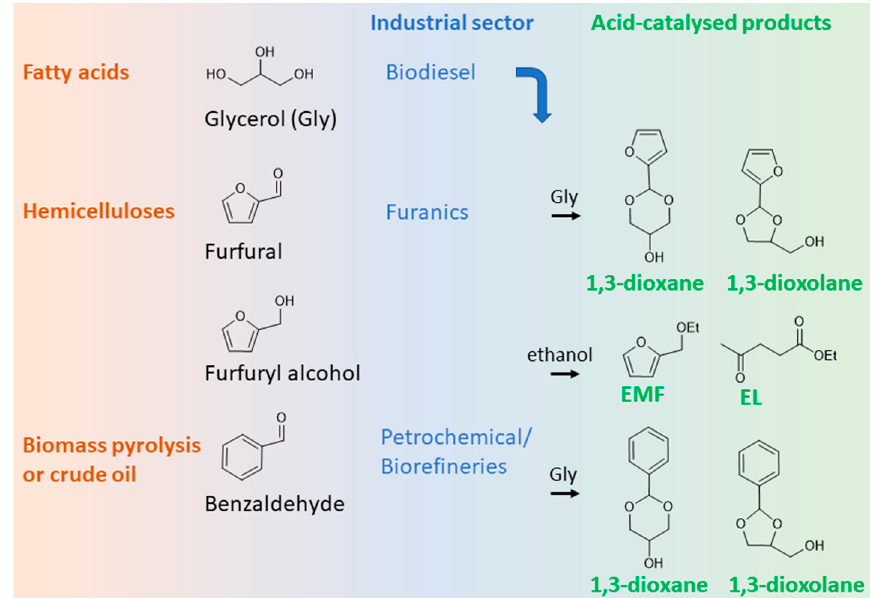
Scheme 1. The chemical valorization/repurposing of biomass-derived chemicals such as furfural (Fur), furfuryl alcohol (FA) and glycerol (Gly). The reactions of Fur/Gly and benzaldehyde/Gly to useful cyclic acetals, and FA/ethanol to furanic ether (EMF) and levulinate ester